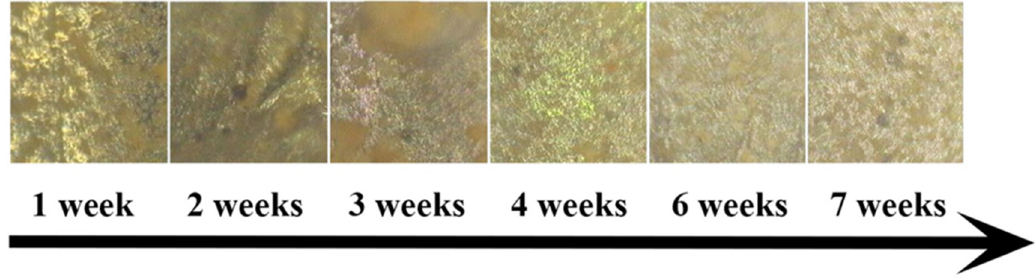
Figure 3. Images from the surface of chalcopyrite after bio-interacting with bacterial cells of Acidithiobacillus ferrooxidans at one-to-seven weeks of bioleaching. The FTIR measurements presented in Figure 2 are correlated, respectively, with the 100 × 100 µ m images.